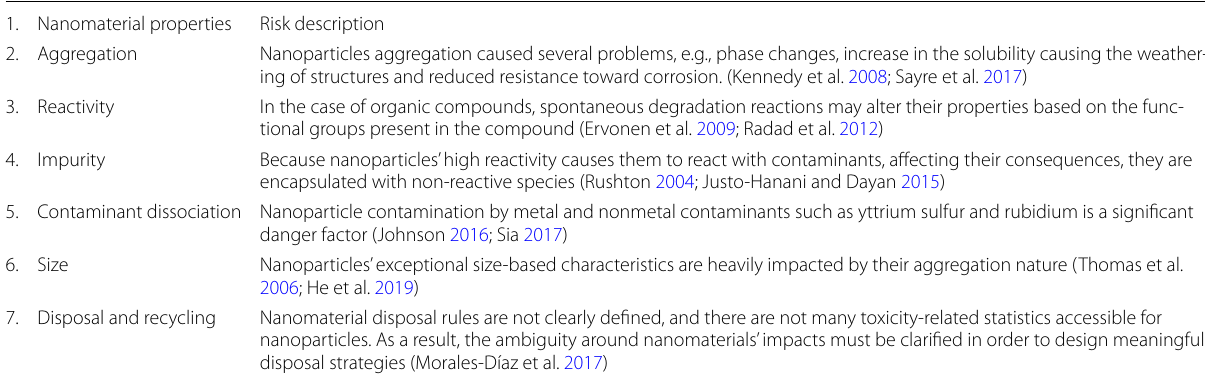
Table 5 General characteristics and risks of